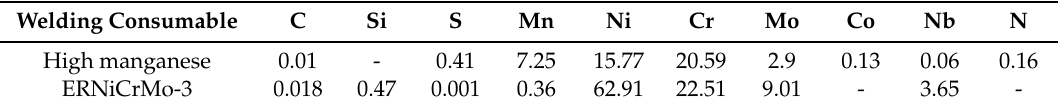
Table 3. The chemical composition of welding consumables [13].